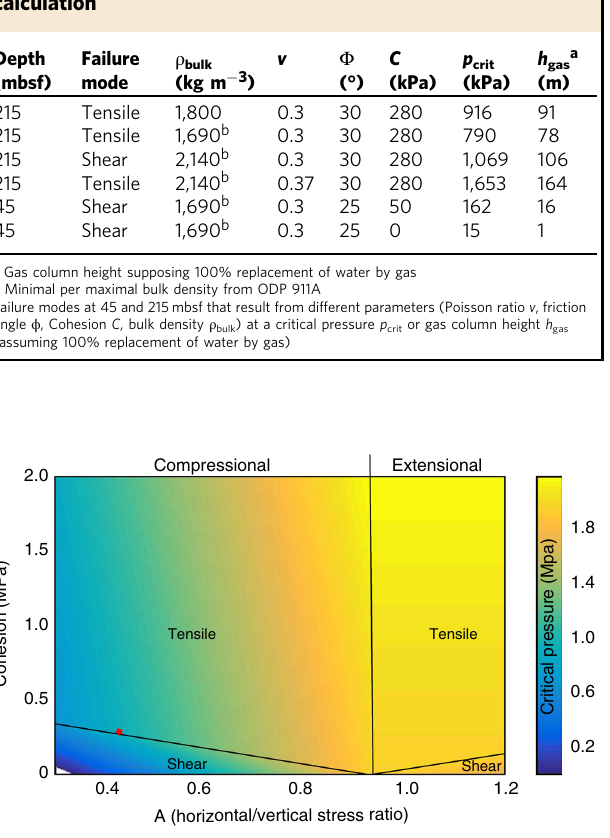
Table 1 Parameters and results of critical overpressure